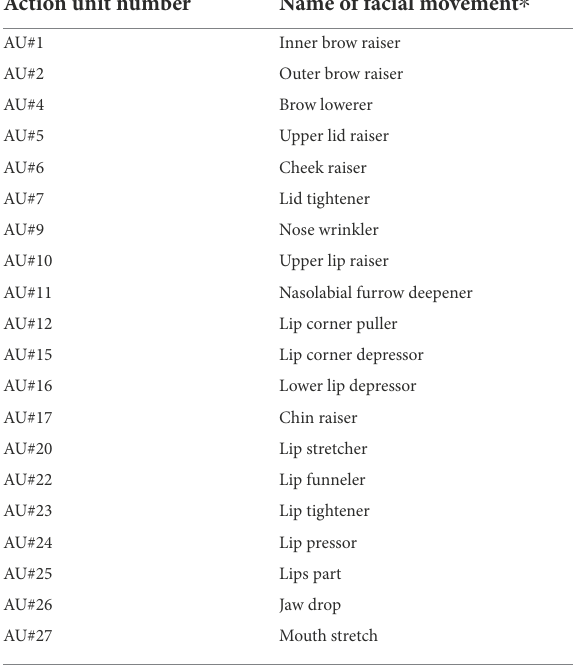
TABLE 1 List of action units (AUs) analyzed in this